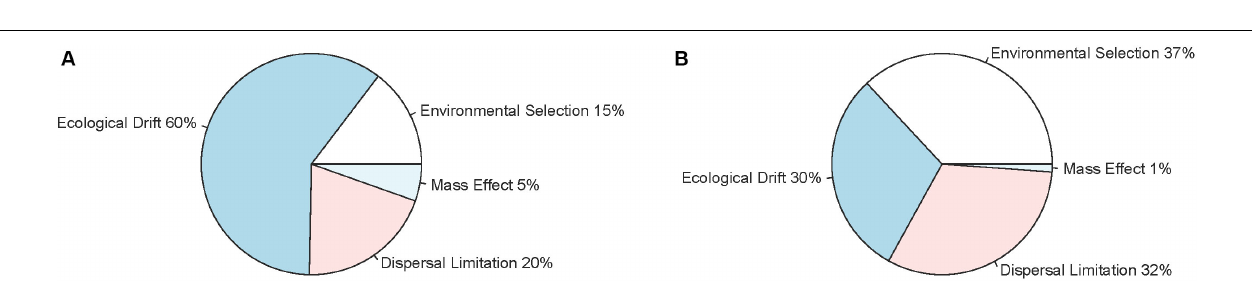
FIGURE 3 | Relative importance of environmental selection, mass effects, dispersal limitation and ecological drift for the variation of intestinal microbial communities among perch (A) and roach (B) as obtained from null model analysis.